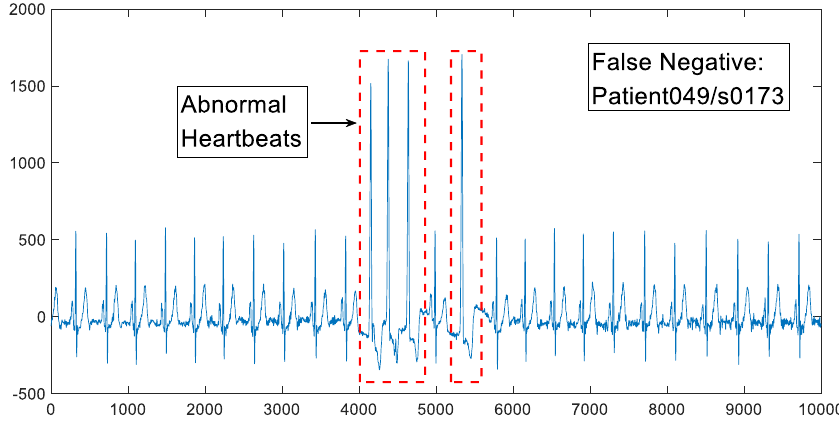
Figure 8. The ECG waveform of a false negative sample.